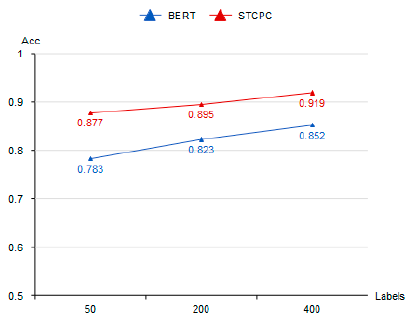
Figure 7. IMDb dataset training results.